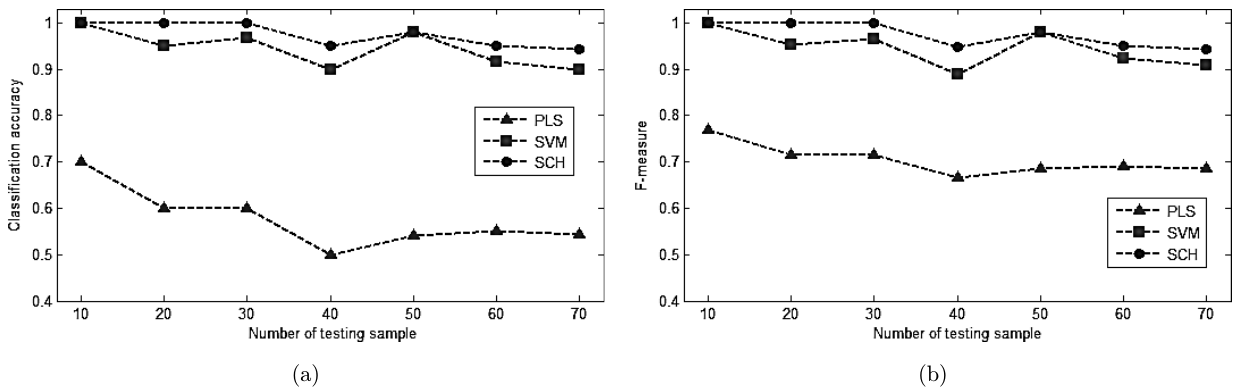
Fig. 5. The classi¯cation accuracy for the di®erent manufacturers